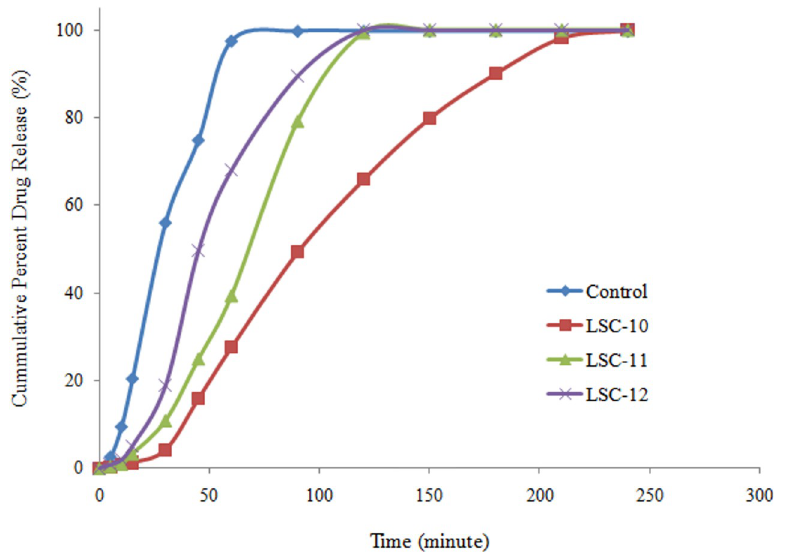
Fig 8. Drug release from liquisolid compacts containing different concentrations of HPMC.